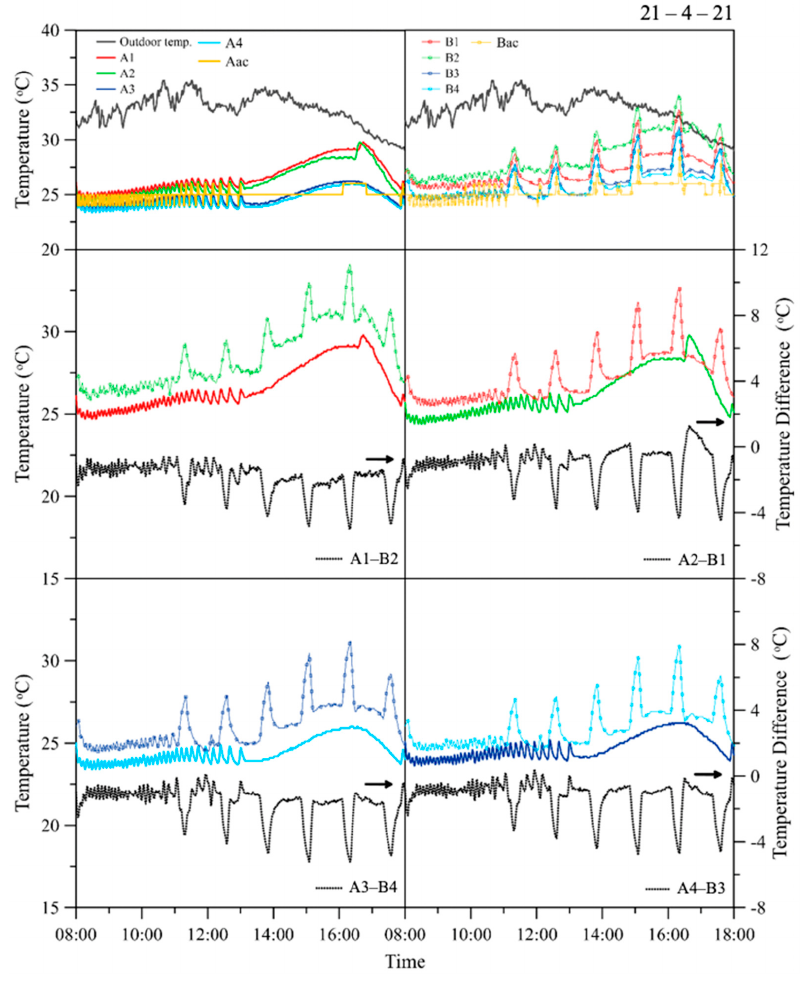
Figure 6. Temperature and temperature differences of rooms A and B (day 1).